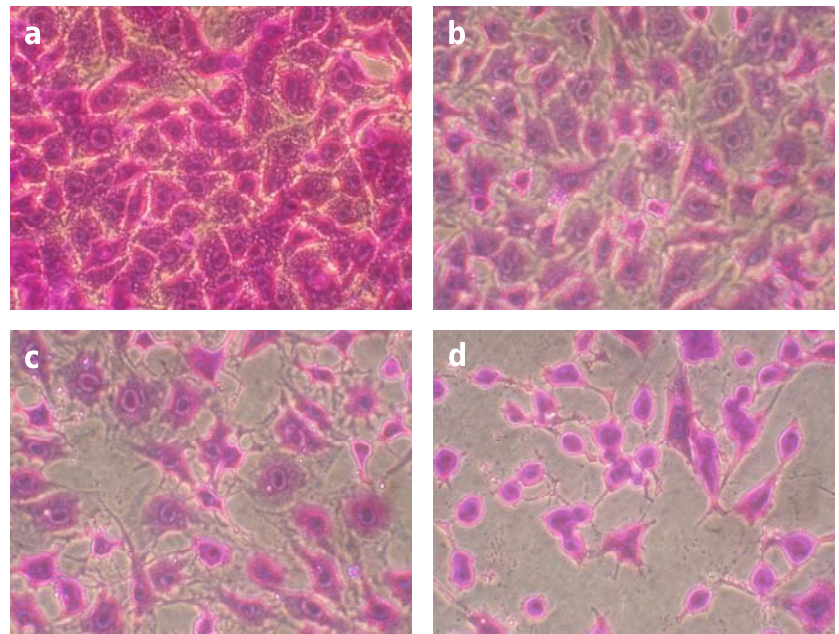
Figure 2. Effect of NOS-6 on mouse fibroblasts (BALB/c cells). Cells were treated with 1, 5 and 10 µM for 24 h (B-D). Control cells (A) were treated with DMSO (0.5%; v/v) for 24 h under the same conditions. Cells were fixed and stained by crystal violet (2% in 20% methanol). Magnification was 400×.